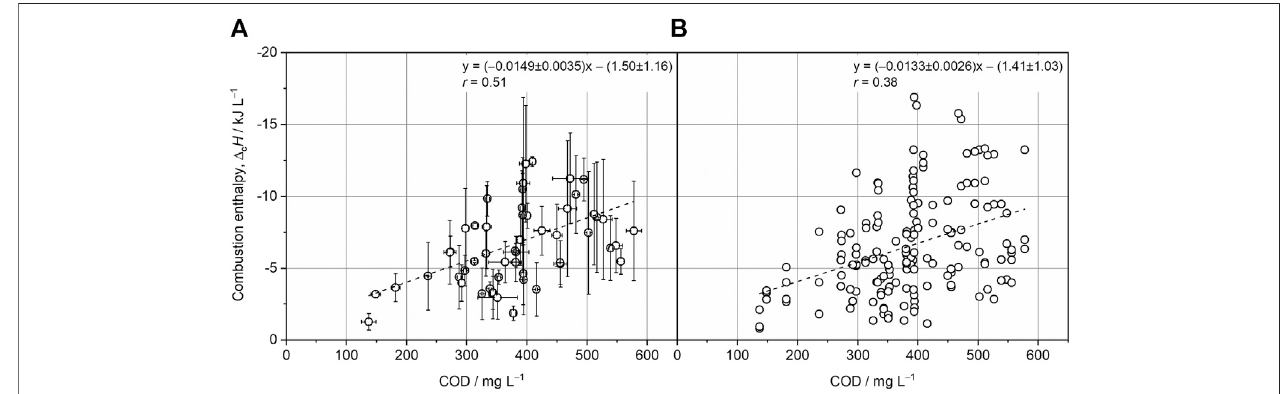
FIGURE2| Linear regressionanalysiswiththeCODofwastewatersamplesand therespectivecombustion enthalpies( Δ c H )derivedfromfreeze-dried wastewater samples. (A) Average values of composite samples ( n (cid:2) 53) and (B) single combustion measurements thereof ( n (cid:2) 158) are shown. Error bars indicate standard deviations.